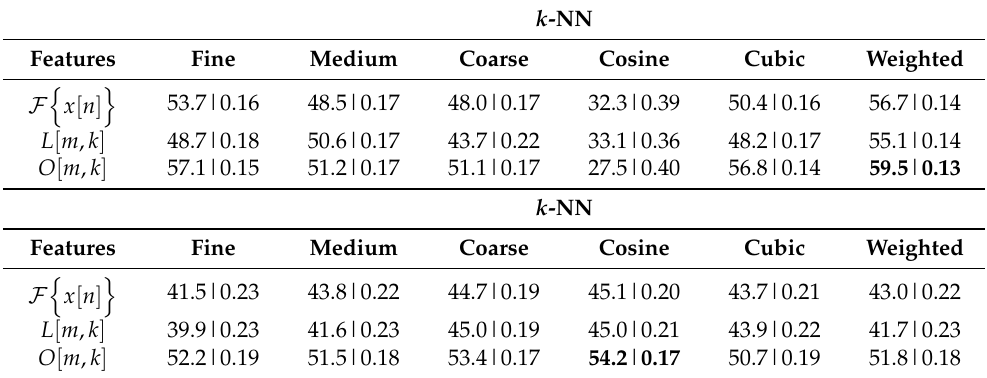
Table 4. Linear wear-state classification results ( % ) and MAE (normalised) for STFT feature sets, where G denotes Gaussian.